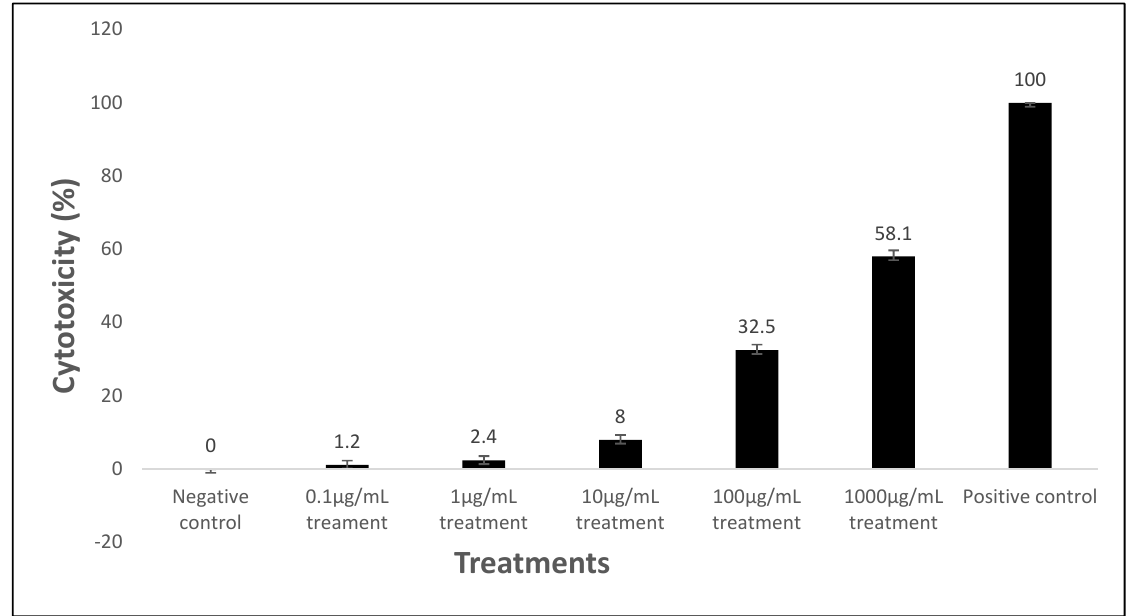
Table 6. Varying combinations of organogel–hydrogel mix for bigel formation.